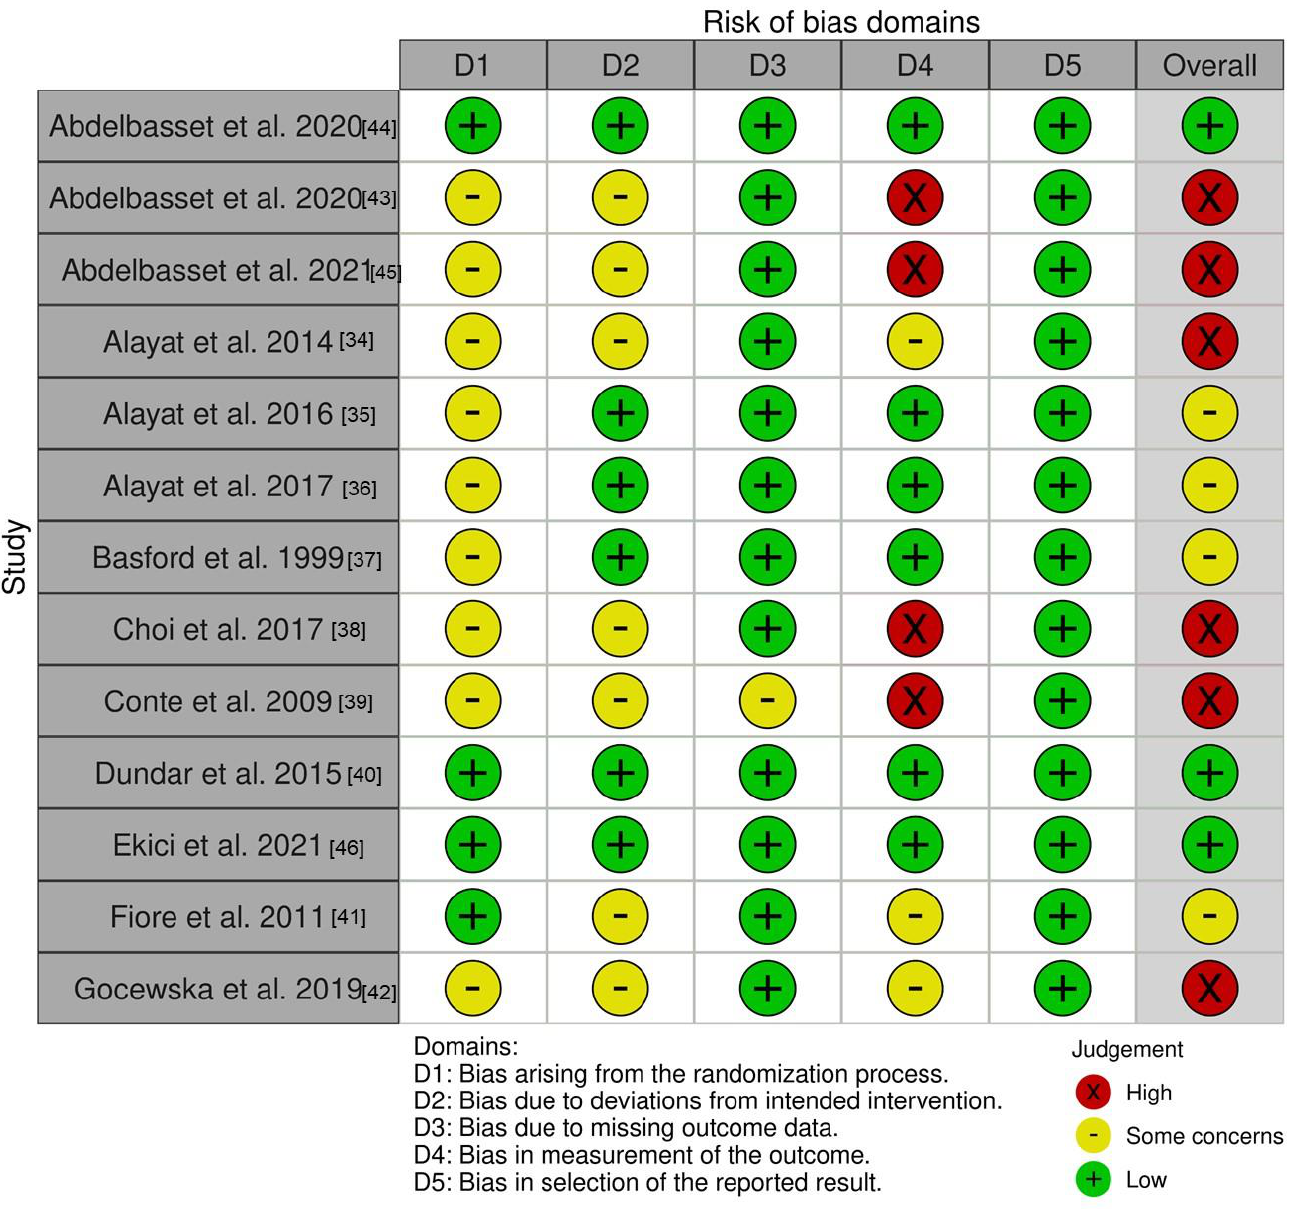
Figure 4. Risk of bias (RoB) of included musculoskeletal pain studies assessed with